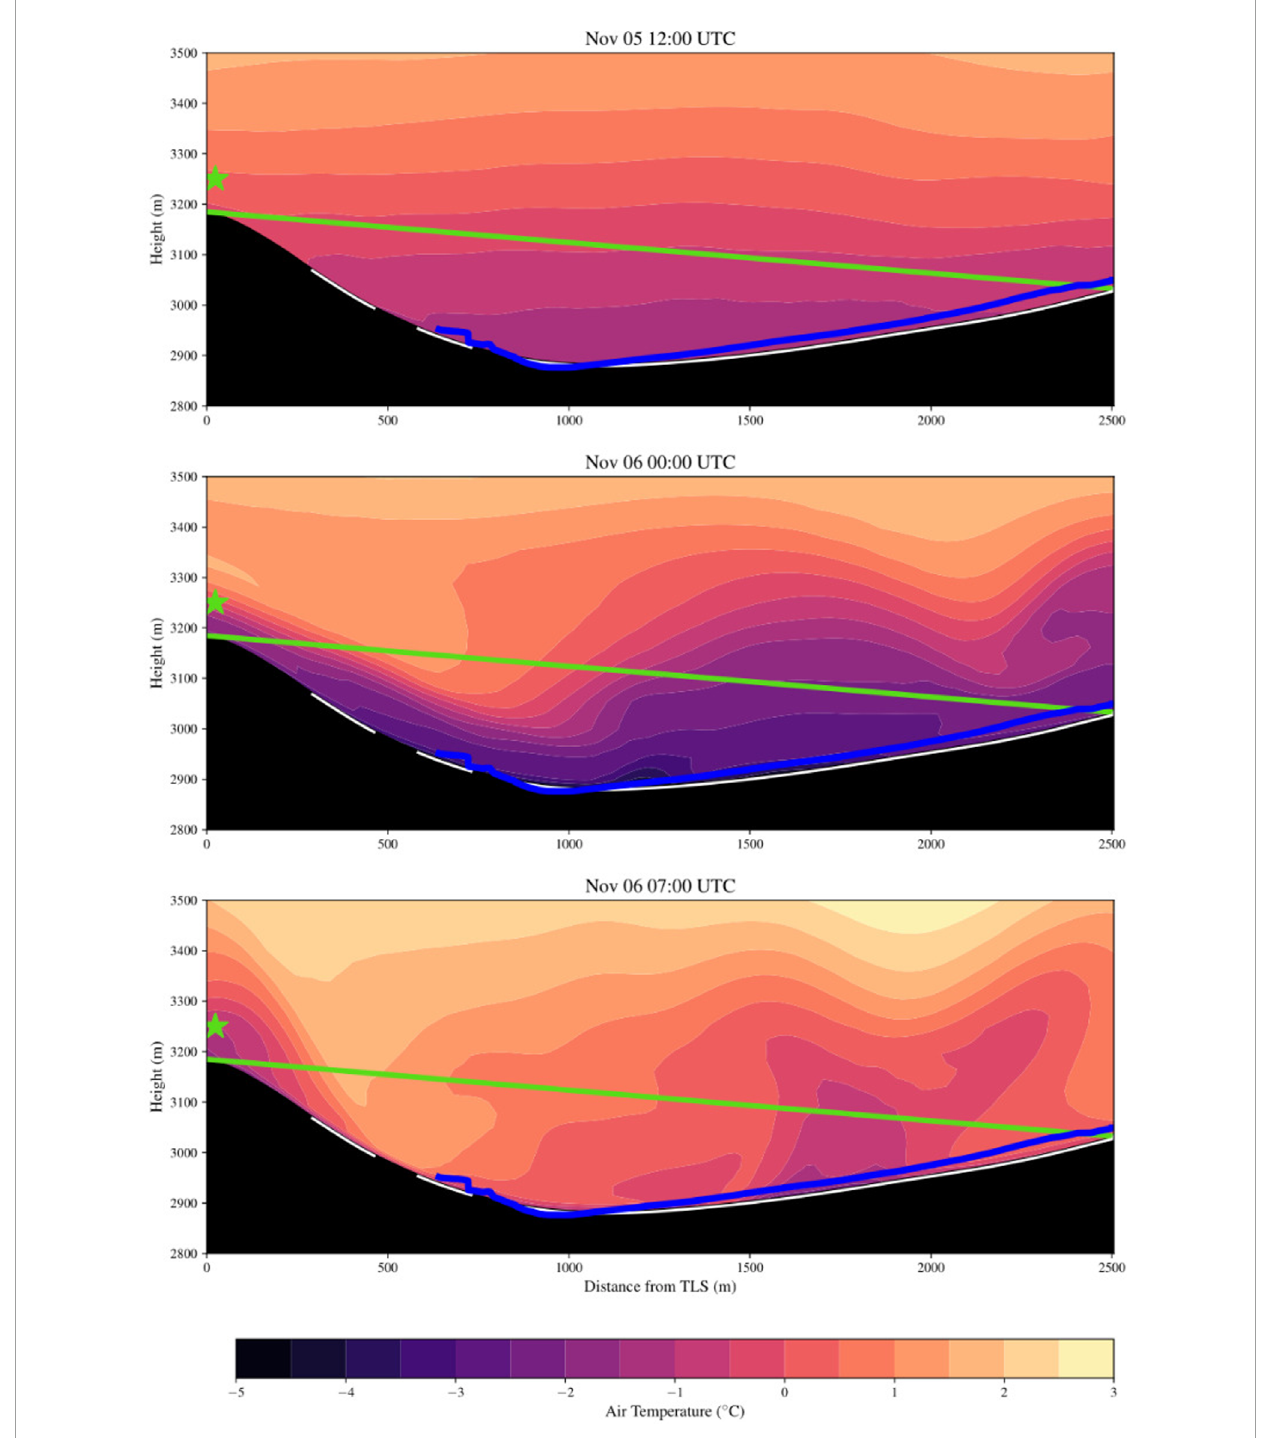
FIGURE 6 Temperature plot for the cross-section from TLS to area 4 for 5 November 12:00 UTC, and 6 November 00:00 and 07:00 UTC. The black area is the topography as used in the simulation, with white areas indicated as the glacier area. The blue line is the topography as measured with the TLS. The green line is the laser beam in the simulation and the green star is the position of the TLS in